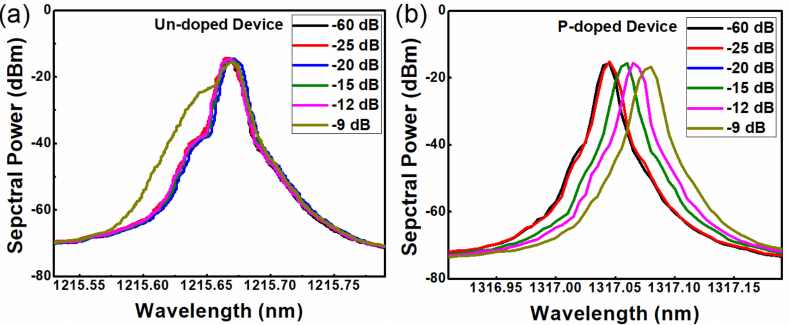
Figure 5. The optical spectra of devices with di ff erent optical feedback intensities. ( a ) Un-doped device and ( b ) p-doped device.